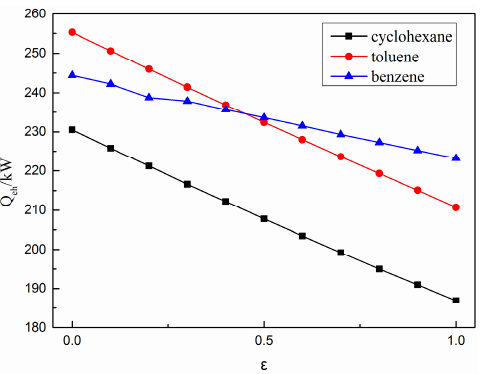
Figure 3 . Effect of regenerator efficiency on heat absorption of high temperature cycle evaporator.